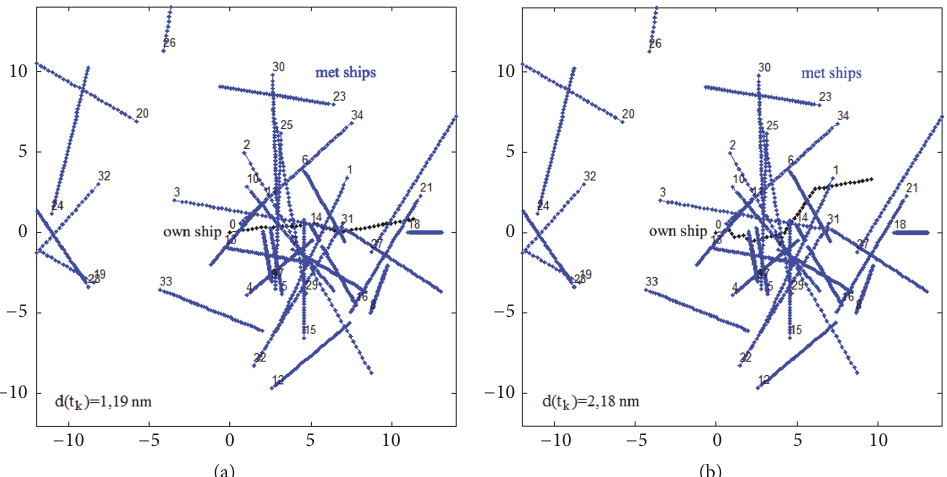
Figure 5: Safe trajectory of own ship in the situation of passing with 𝐽 = 34 met ships, determined by the positional cooperative game algorithm.